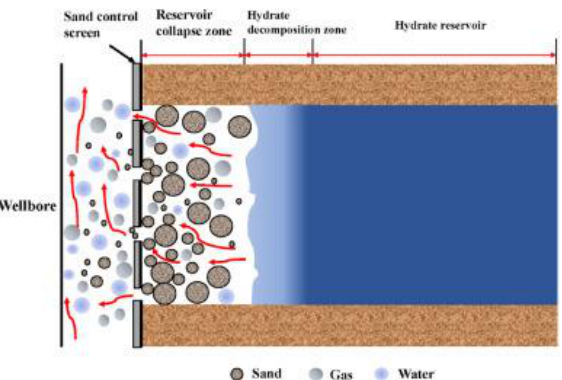
Figure 6. Schematic diagram of sand control in the exploitation of a vertical well in the NGH reservoir [This figure was modified with permission from ref [144]. Copyright 2022, Elsevier].